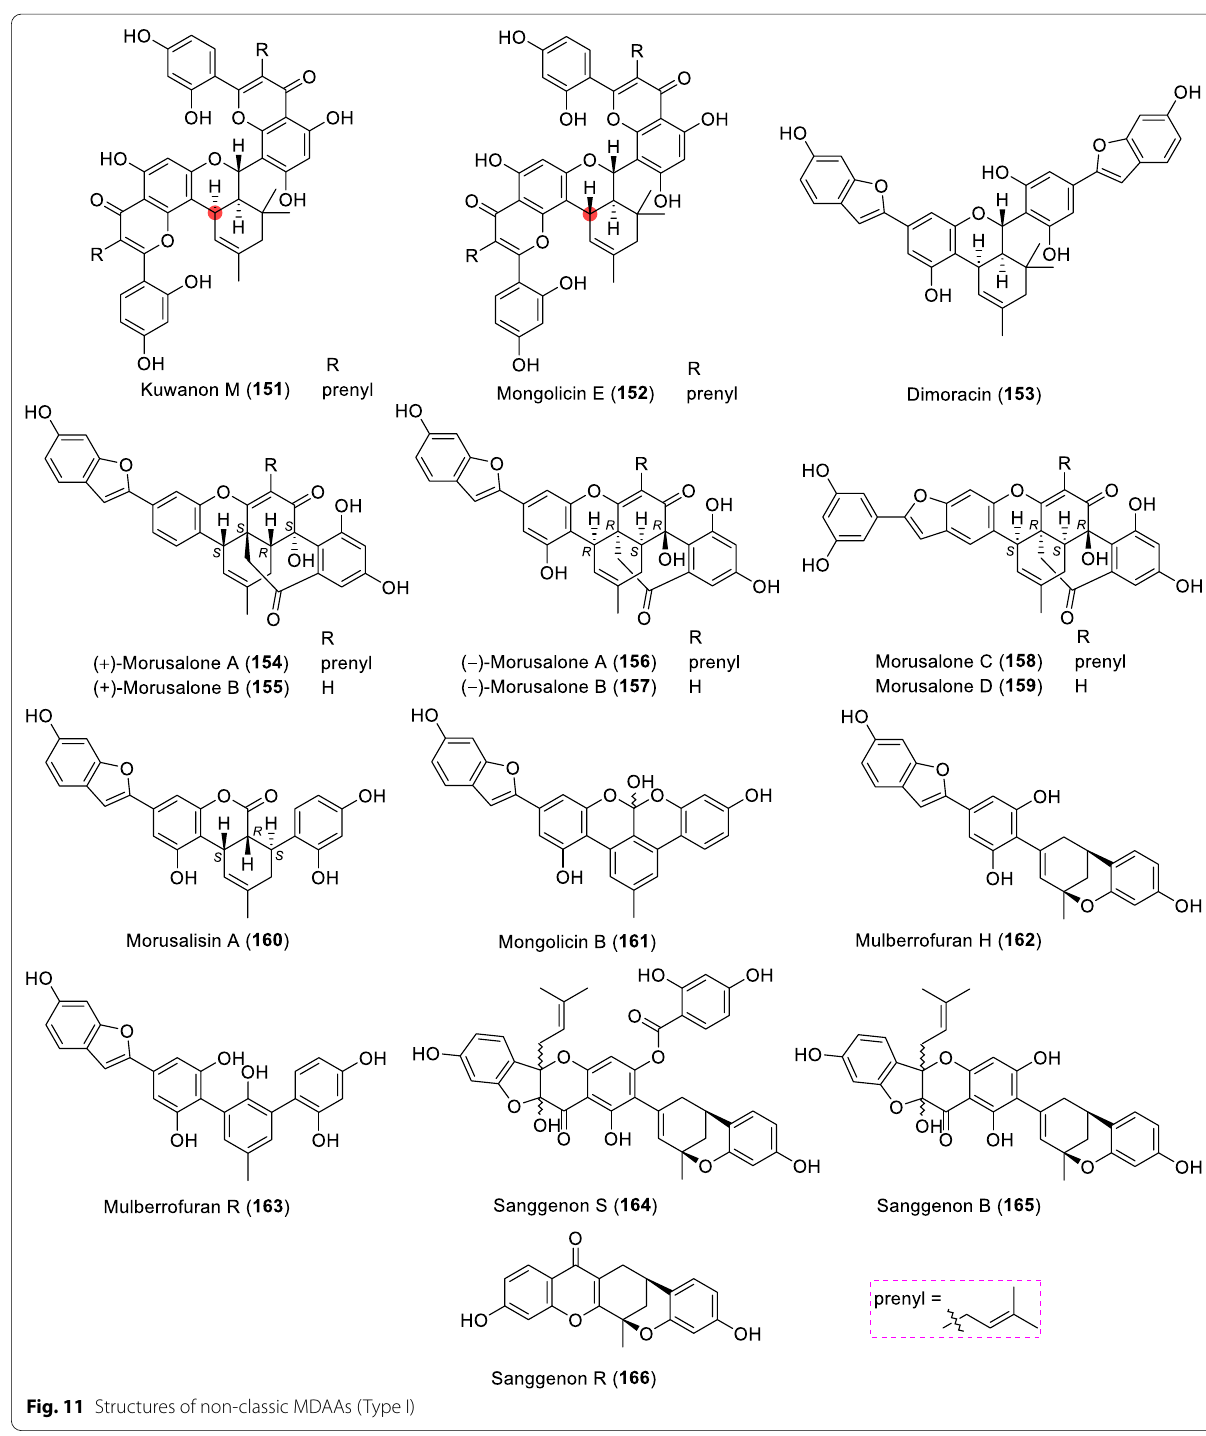
Fig. 11 Structures of non‑classic MDAAs (Type